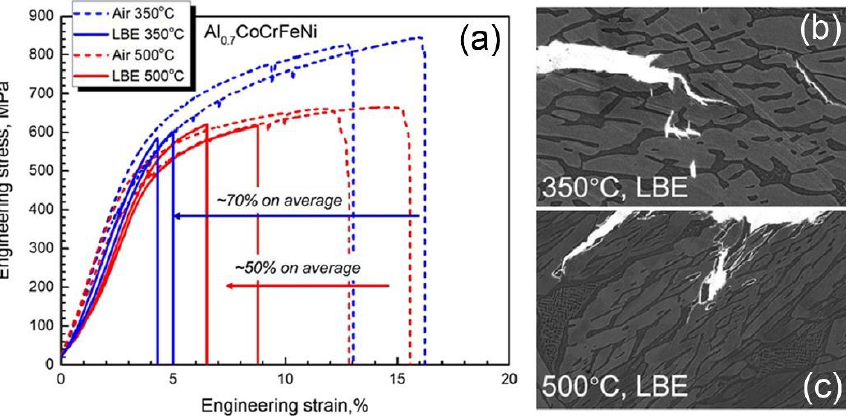
Figure 12. Liquid metal embrittlement of Al0.7CoCrFeNi HEA exposed to oxygen-saturated LBE. ( a ) Engineering stress-strain curves tested in air and LBE at different temperatures. ( b , c ) SEM images after LBE corrosion [89]. Figure 12 is reprinted with permission from Reference [89]. Copyright 2021 Elsevier.